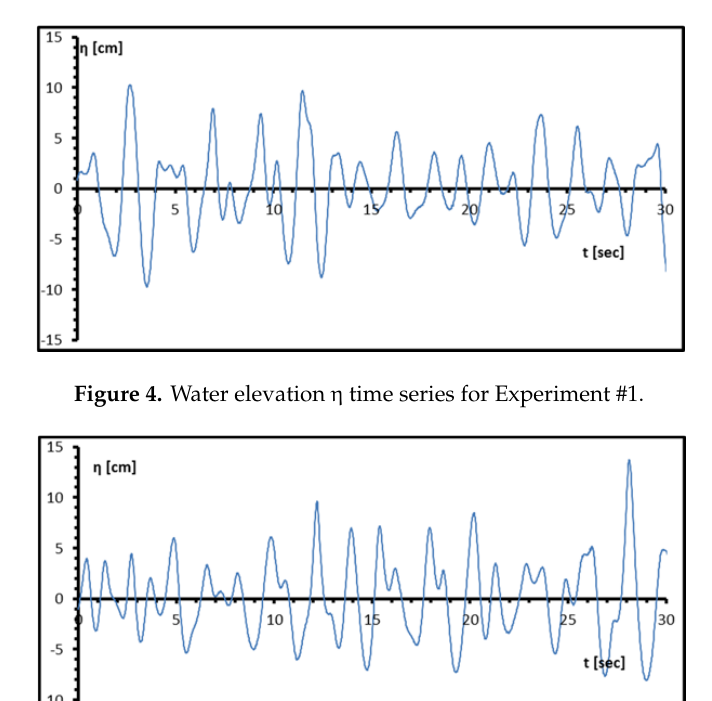
Figure 6. Water elevation η time series for Experiment #3. Figure 7. Water elevation η time series for Experiment #4. Figure 8. Water elevation η time series for Experiment #5.